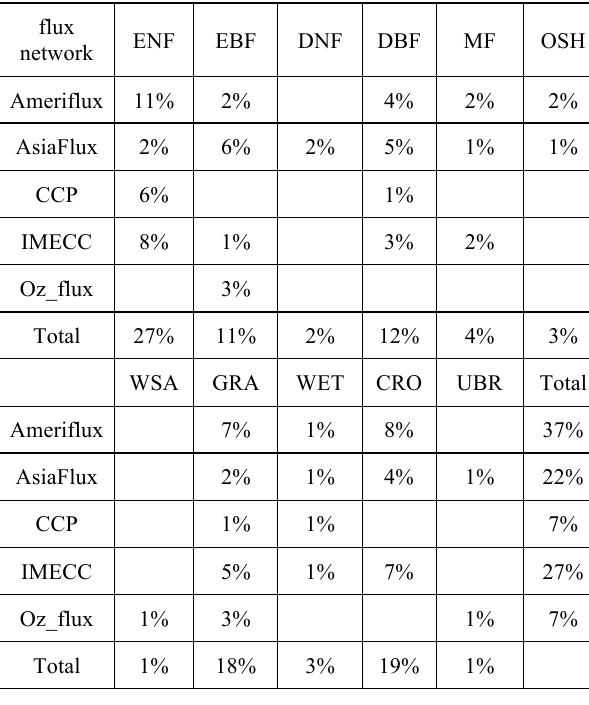
Table 4. The percentage distribution of IGBP classes of quality- level-1 reference data (192 points) for each flux